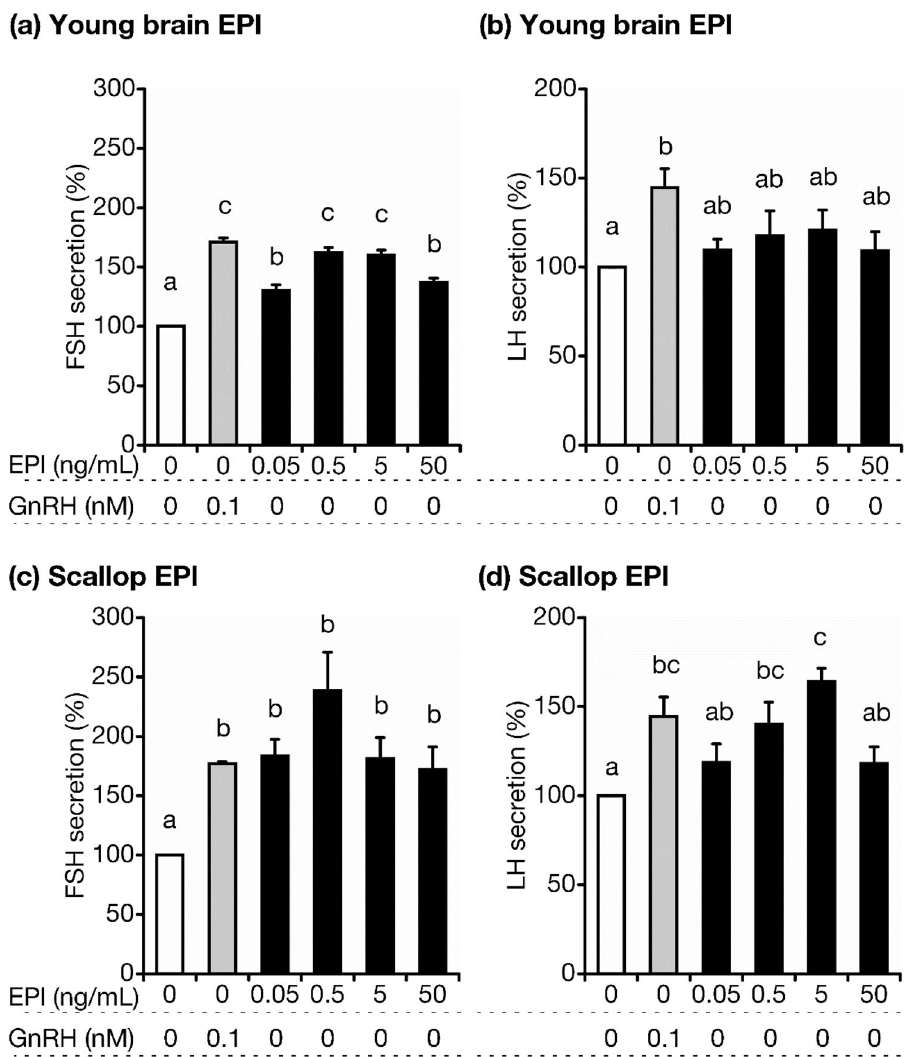
Figure 1. Effects of various concentrations of young heifer brain-derived EPls ( a , b ) or scallop-derived EPls ( c , d ) in media lacking GnRH on FSH ( a, c ) and LH ( b, d ) secretion by cultured AP cells. FSH and LH concentrations in control cells (cultured in a medium lacking EPls and GnRH) were averaged and set as 100%. The mean LH or FSH concentrations in each treatment group were expressed as percentages of the control value. Bars are labeled with different letters (a, b, and c) to indicate different stimulatory effects ( P < 0.05; details of P -values are presented in Supplementary Tables S1–S4 online). Bars labeled with the same letter indicate a similar stimulatory effect. Statistical analysis was conducted using the Tukey–Kramer test. AP, anterior pituitary; scallop EPl, scallop-derived ethanolamine plasmalogen; GnRH, gonadotropin-releasing hormone; FSH, follicle- stimulating hormone; LH, luteinizing